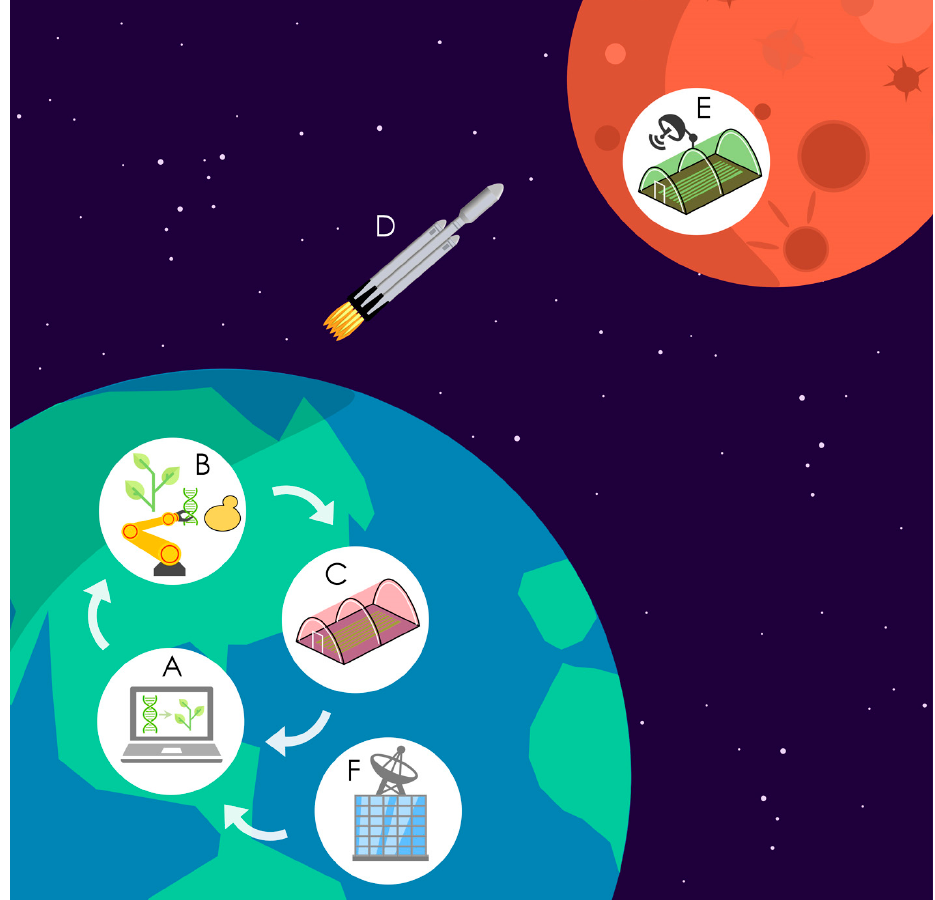
Figure 3. Schematic roadmap for research on adapting life to Mars. The Mars Biofoundry integrates the design of synthetic biology approaches ( A ) with an automated platform for implementing bioengineering designs in plants and microbes ( B ) and a facility for high-throughput phenotyping under simulated Martian conditions ( C ). The process iterates as a design-build-test cycle. Eventually, engineered organisms could be periodically transported to Mars ( D ) to perform experiments within miniature growth facilities ( E ). Remote monitoring of performance on Mars ( F ) would provide critical knowledge to adjust the work carried out at the biofoundry on Earth.